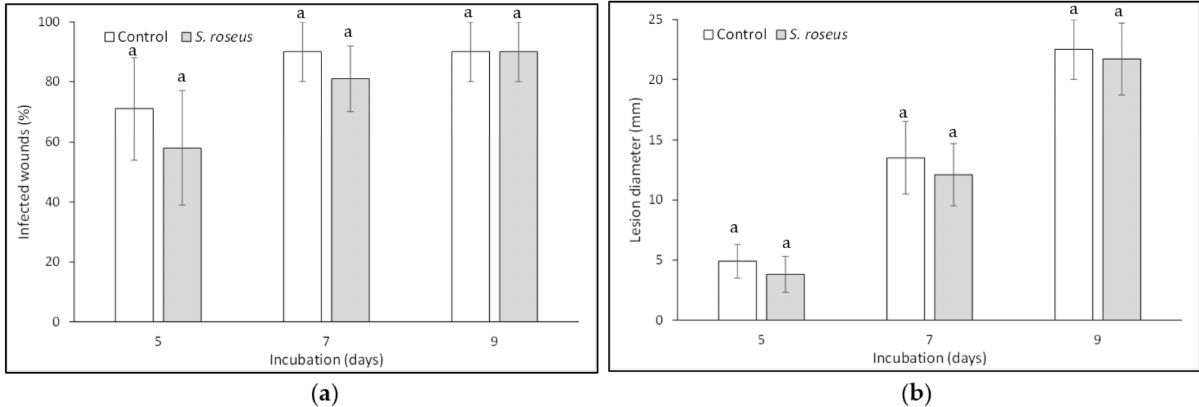
Figure 5. Sporobolomyces roseus effect on blue mold incidence ( a ) and severity ( b ) on Golden Delicious apples. Fruit were wounded, yeast-treated, pathogen-inoculated, and stored at 20 ± 1 ◦ C for 9 days in the dark and high relative humidity. An exogenous source of C was also added. Data are the mean of three replicates ± standard error of the mean (SEM). Bars with different letters are statistically significant ( p ≤ 0.05) according to Duncan’s Multiple Range Test